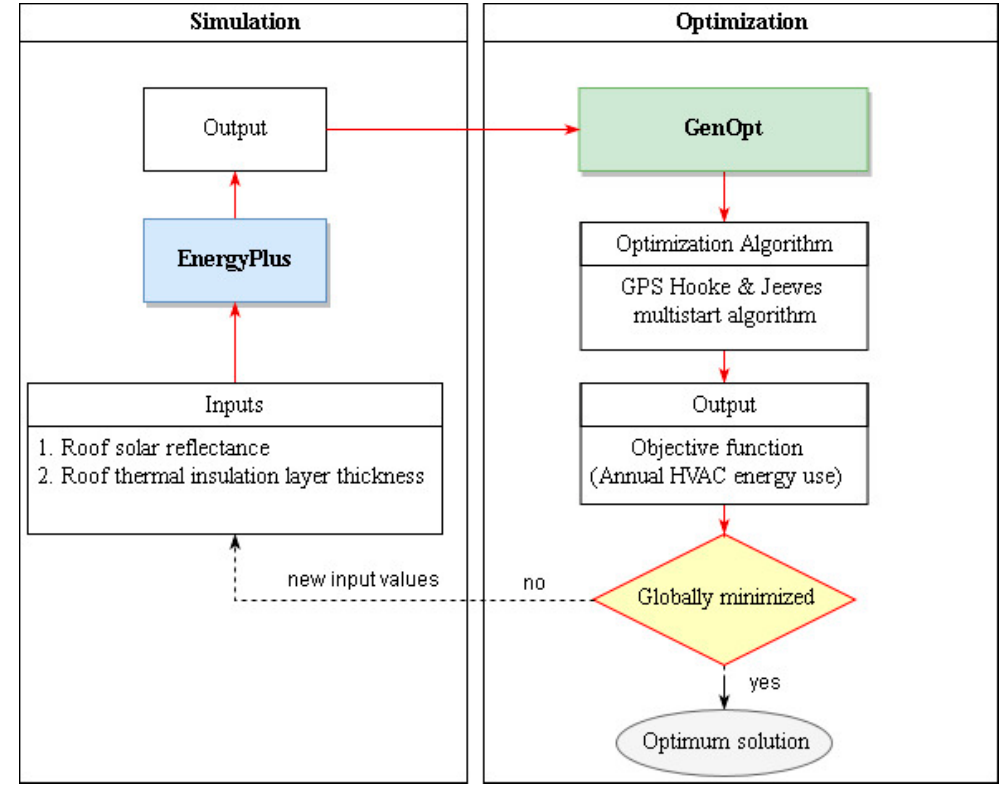
Figure 1. Schematic view of the methodology.